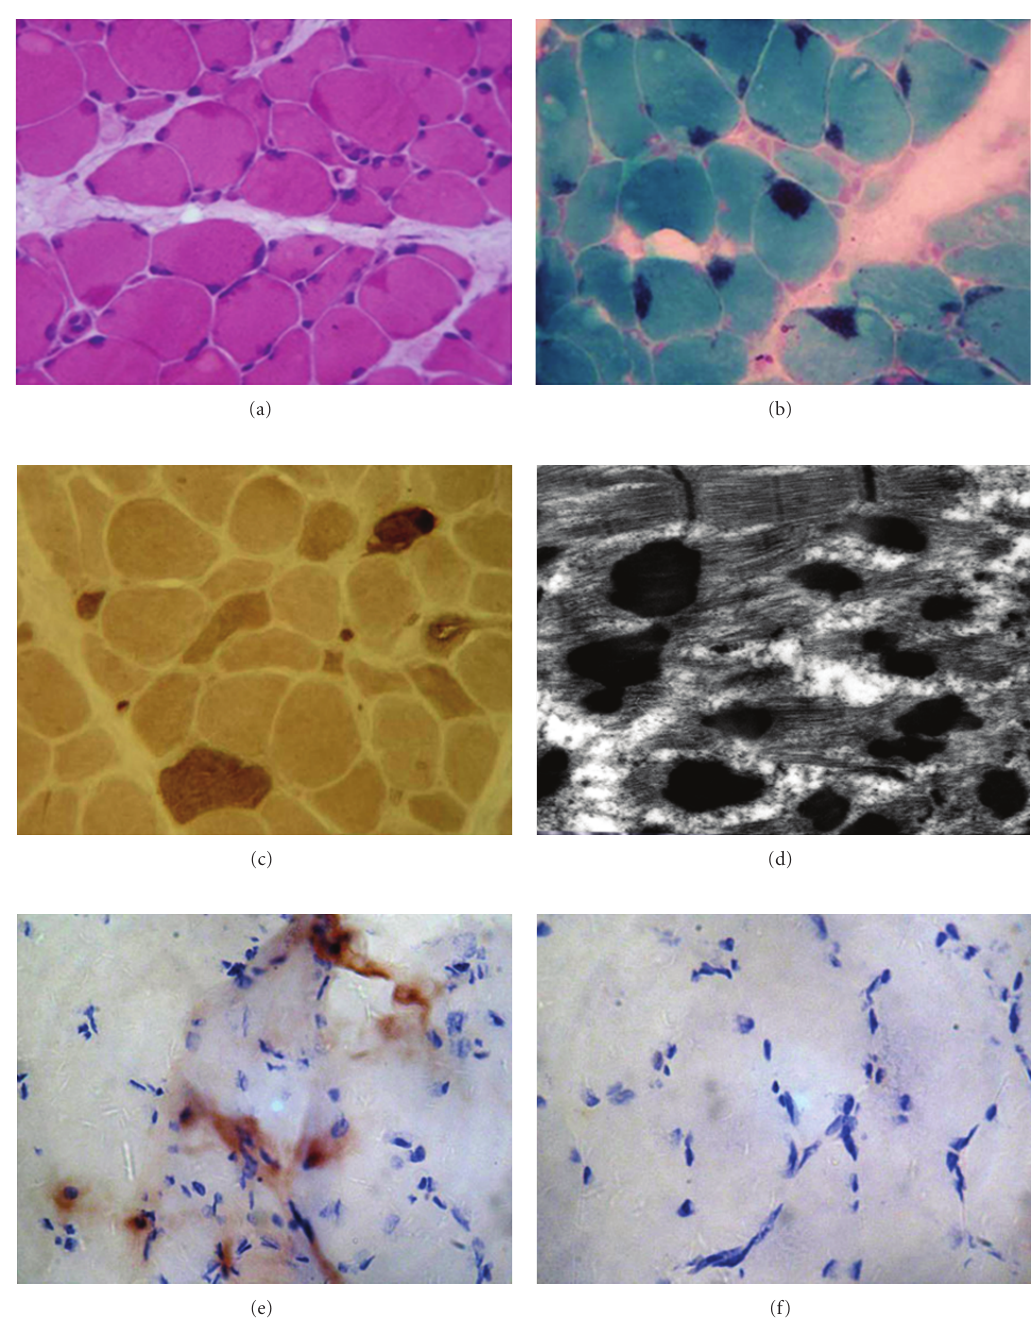
Figure 1: (a) HE staining revealed inequality of size of muscle fibers and a lot of emarcid muscle fibers and compensatory hypertrophic muscle fibers. Some dark red uniform of eosinophils matters was observed among some of the muscle fibers. Magnification × 400. (b) Modified Gomori trichrome (MGT) staining showed dark blue rod-like structures or nemaline rods, and abnormal red fiber was not found. Magnification × 400. (c) Histochemistry of ATP enzyme staining demonstrated abnormal distribution of type I (predominated) and type II (rare) muscle fibers. Magnification × 400. (d) Lead-uranium double staining demonstrated myofibril disorderly arrayed, and a large number of nemaline body under the sarcolemma and between the myofibril, and electron dense nemaline bodies of Z-band origin on ultrastructural examination. Magnification × 12000. (e), (f) Immunohistochemical results of the two specimens with necrotic muscle fibers showed that CD4 positive cells and some other cells were gathered among the muscle fibers (e), but CD8 positive cells were not found (f). Magnification ×